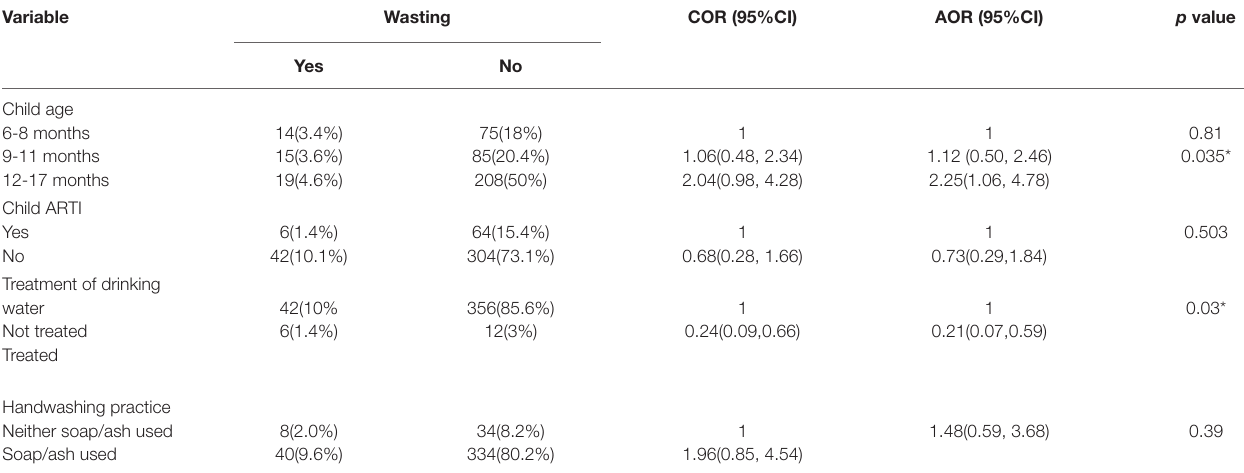
TABLE 9 | Factors associated with wasting in Dessie town, Northeastern Ethiopia,